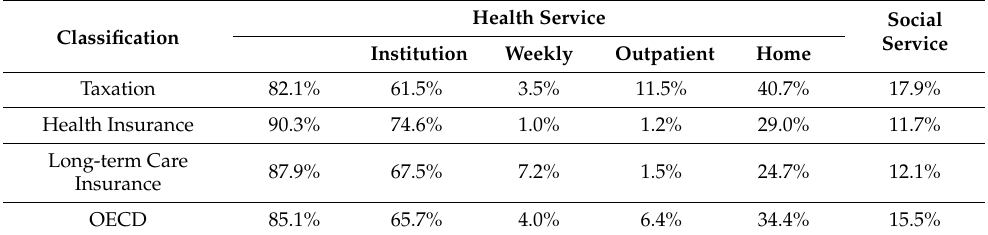
Table 5. Expenditure ratios by health and social long-term care benefit type [2].